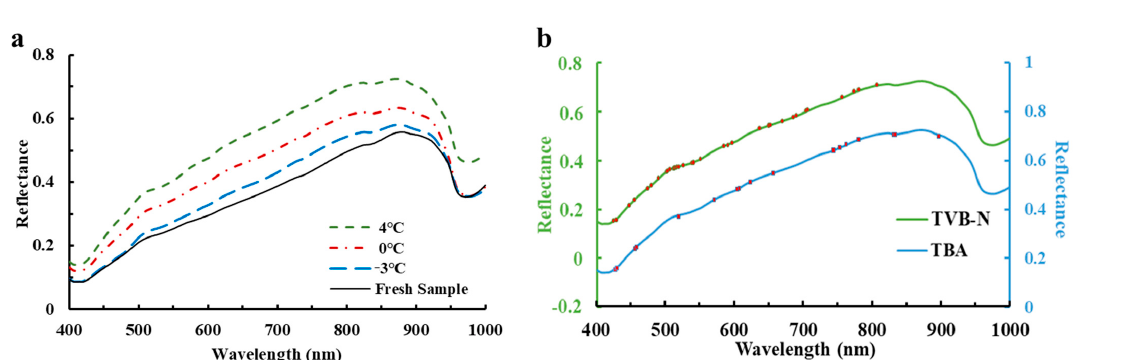
Figure 2. ( a ) Average spectral curves of the examined large yellow croaker fillet after 8 days’ storage; ( b ) Distribution of optimal wavelengths in full reflectance spectra.